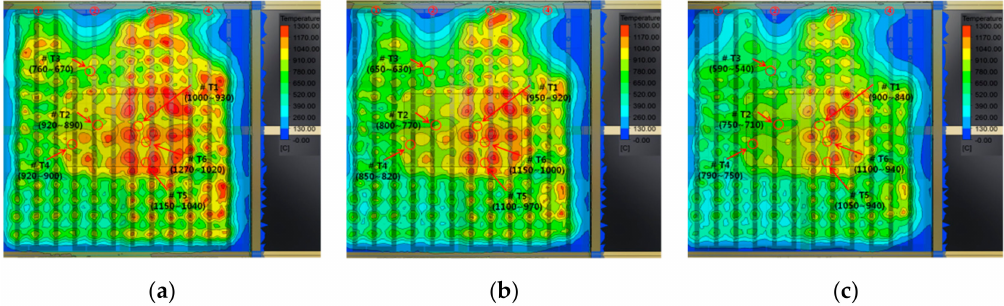
Figure 9. Simulation results for prototype test apparatus: ( a ) 35 kg / h LPG supply to modules 1 & 2 and 50 kg / h LPG supply to modules 3 & 4; ( b ) 15% fuel cut in each module; ( c ) 30% fuel cut in each module.